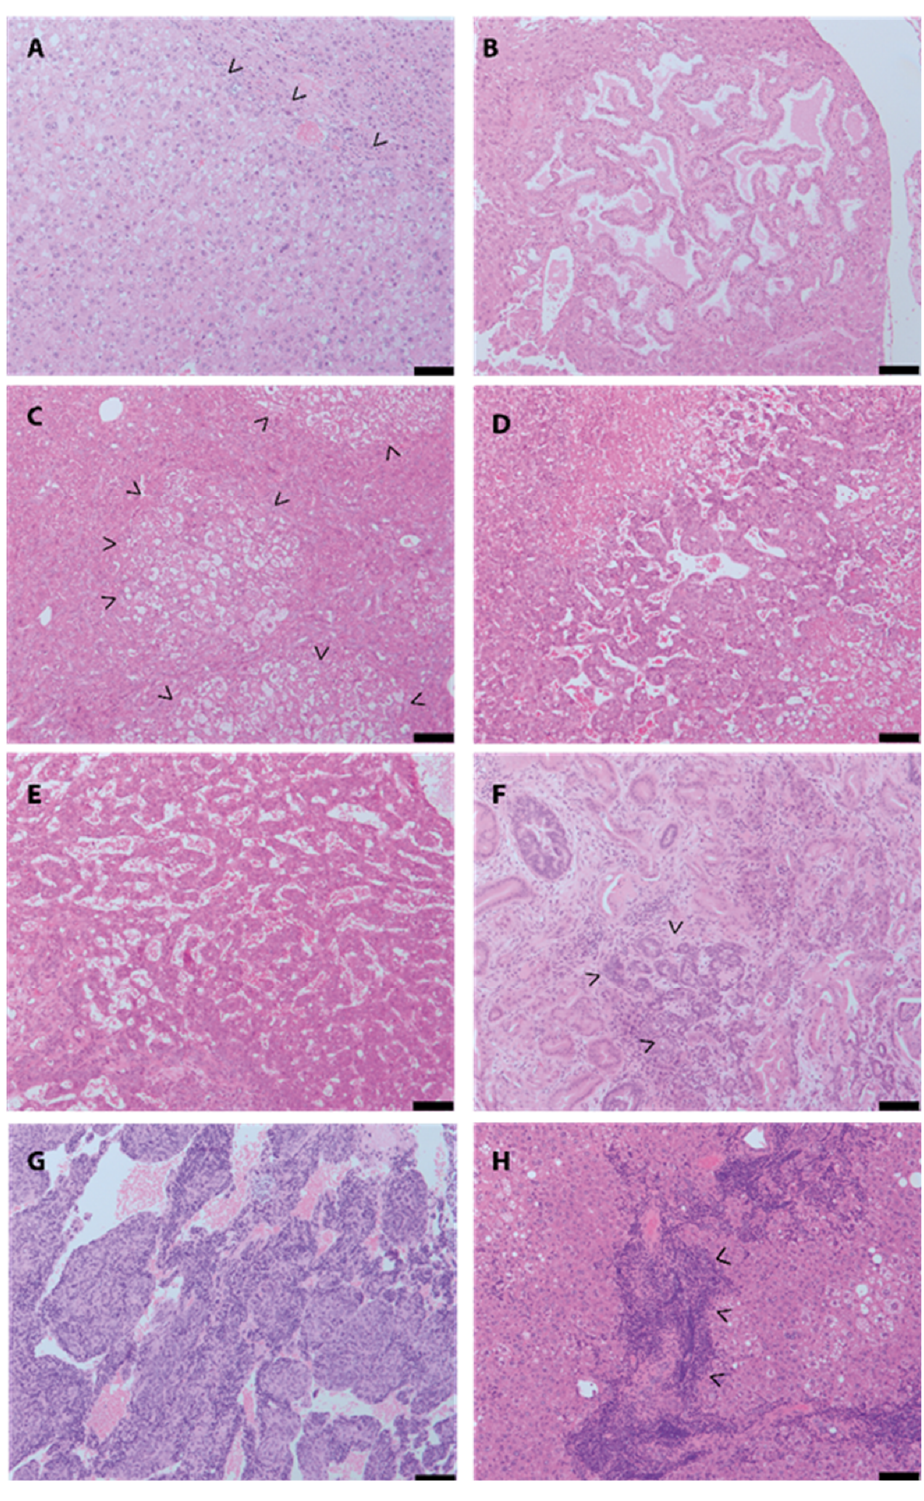
Figure 1. Spectrum of neoplastic lesions identified in genetically engineered mouse models (GEMM) models. ( A ) hepatocellular adenoma; ( B ) bile duct adenoma; ( C ) foci of cellular alterations; ( D,E ) hepatocellular carcinoma, early ( D ) and advanced ( E ) stage, ( F ) cholangiocarcinoma; ( G ) undifferentiated tumors (most probably poorly differentiated hepatocellular carcinoma (HCC)); ( H ) lymphoma. Scale bar: 100 µm, >marks the lesions.